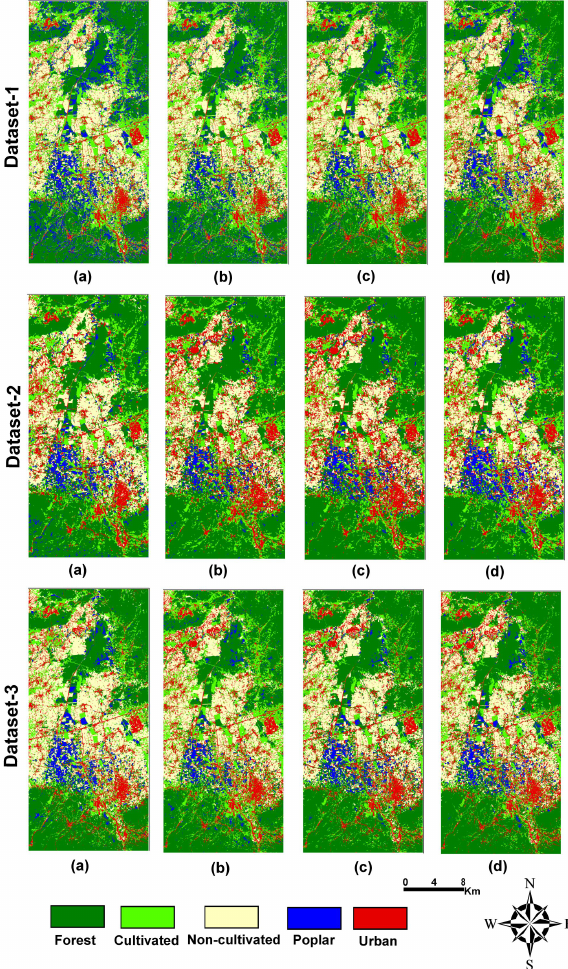
Figure 4: Thematic maps of the study site created by (a) AdaB, (b) RF, (c) RotFor and (d) CCF for all